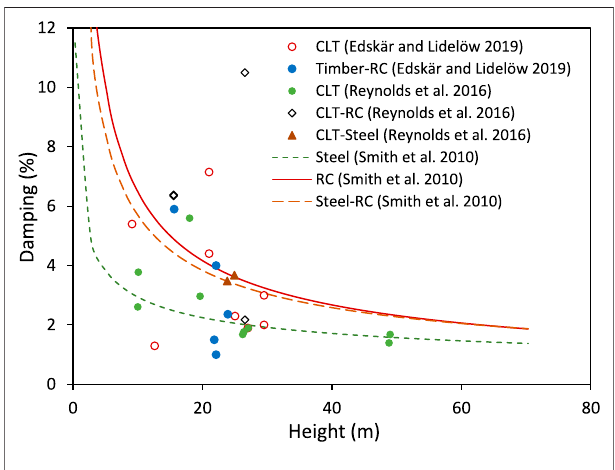
FIGURE 3 | Variation of damping with height. FIGURE 4 | Variation of frequency with